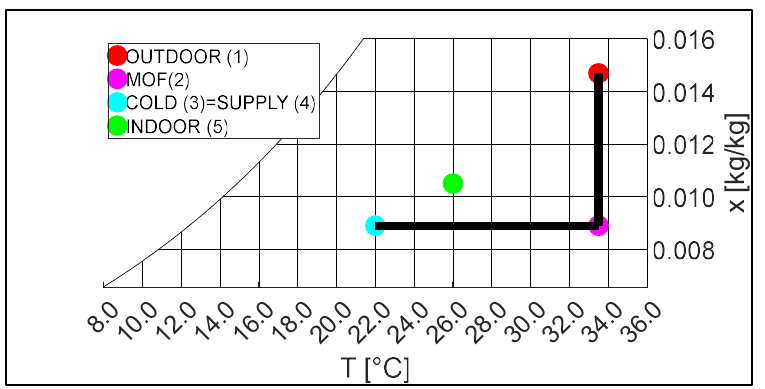
Figure 8. Transformations for HVAC with MOF-assisted dehumidification (case B, scenario 1). Table 4. Cooling power and electric power consumption for the two HVAC configurations.